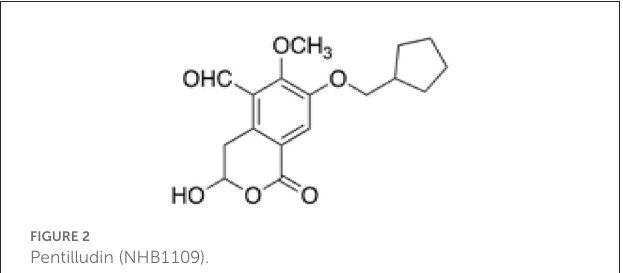
FIGURE2 Pentilludin